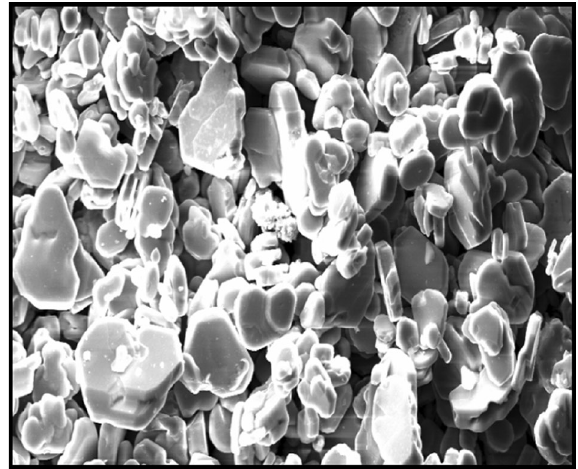
Figure 1. SEM image of TiB 2.